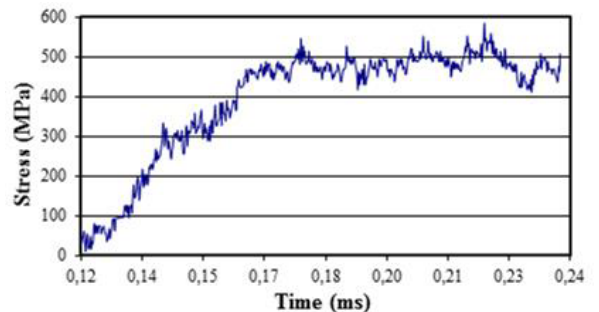
Figure 22. Strain-time curve relating to the modified SHTB with- out the interruption device (Model 2) at a pressure equal to